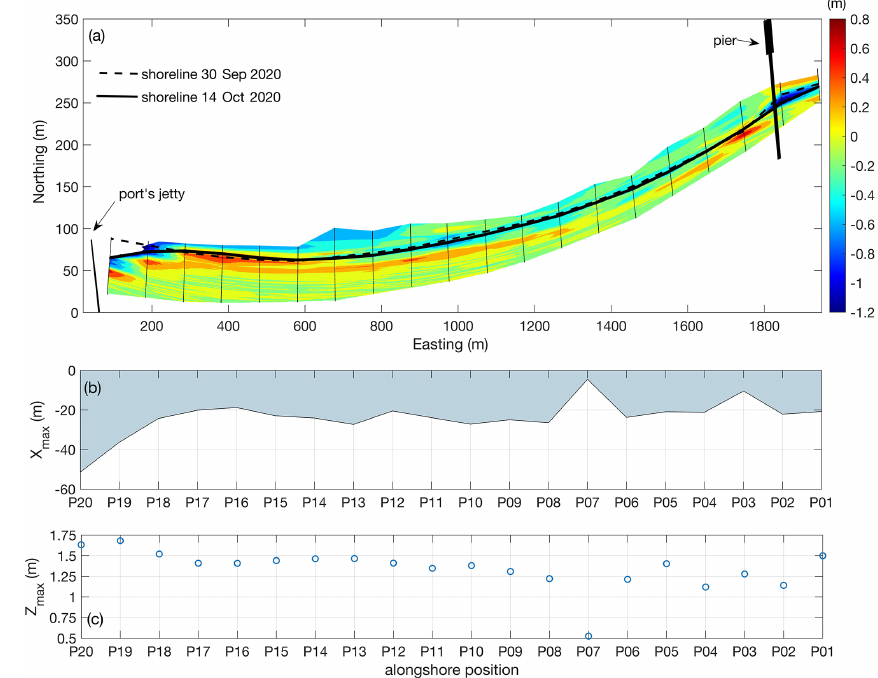
Figure 9. Coastal flooding derived from beach morphology changes east of the Sisal